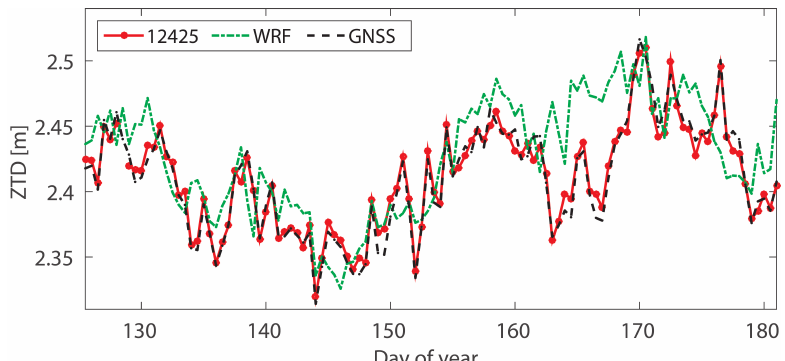
Figure 8. Zenith delays at the location of radiosonde station 12425 retrieved from: radiosonde profile (red solid line), WRF model (dash-dot green line) and GNSS observations (dashed black line). Note the GNSS delays correspond to the altitude of WROC station and are systematically underestimated.